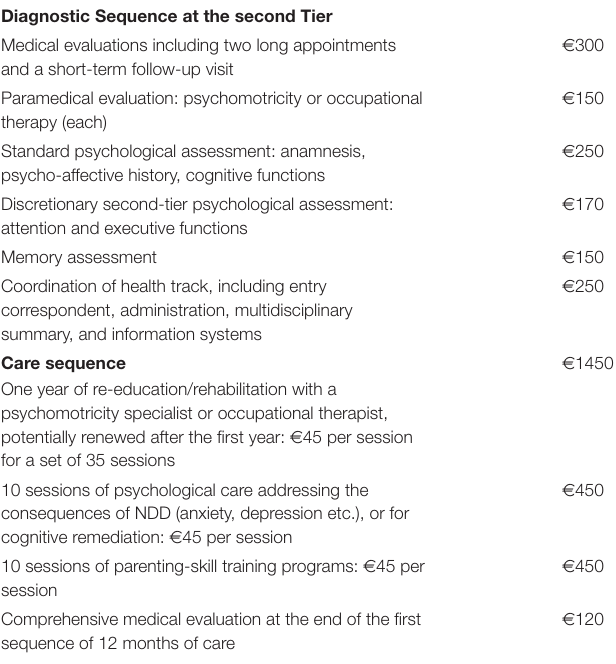
TABLE 3 | Cost by act/sequence during the Experiment “Parcours de Santé TSLA